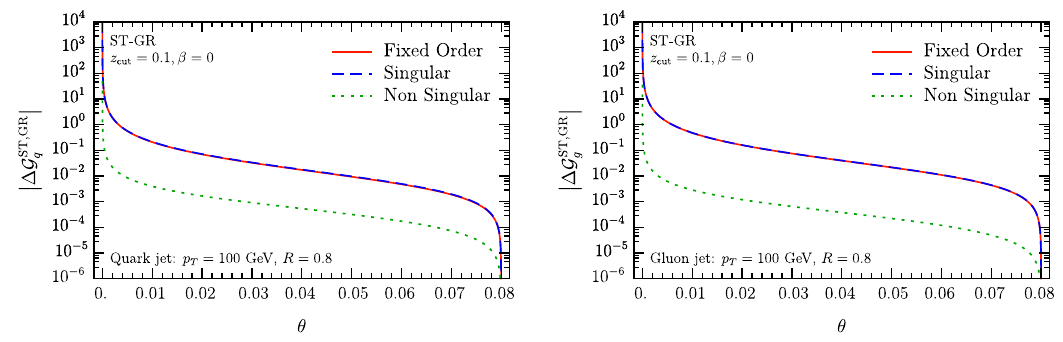
ST ; GR where we include both regions Figure 6 . Testing the refactorization of the jet function (cid:1) G A and B , see eqs. (2.19) and eq. (2.23) at ( (cid:11) s ). We show the full (cid:12)xed order result (solid red), O the singular distributions (dashed blue) and the di(cid:11)erence between the two which corresponds to the nonsingular pieces (dotted green) is the di(cid:11)erence. The left (right) panel corresponds to quark (gluon)